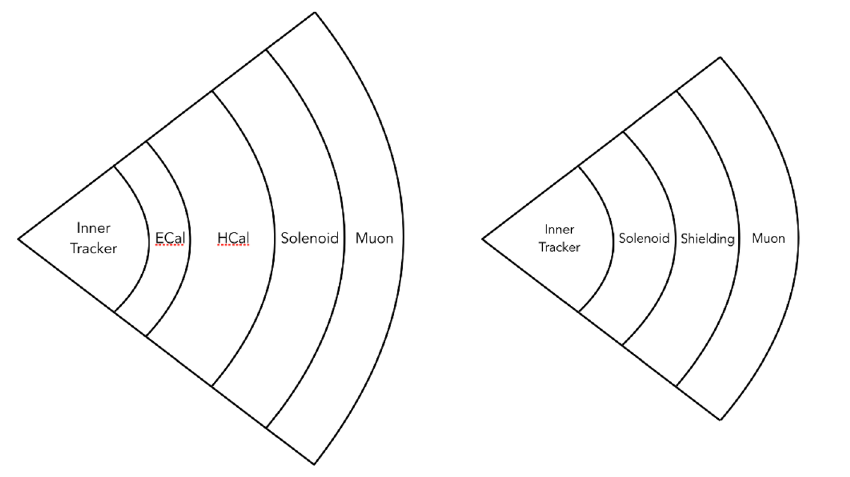
Figure 1 . Cartoon comparing a transverse wedge slice of a general purpose collider detector (left) with a similar slice of a magnetic solenoid tracking detector (right). The inner tracker systems are similar in both detectors. The general purpose detector has electromagnetic and hadronic calorimeter systems outside the inner tracker. The magnitude of the solenoidal magnetic (cid:12)eld in the inner tracker region is similar in both detectors. However, the solenoid can be physically smaller in the tracking detector. In the general purpose detector the return yoke for the solenoid is embedded within the muon system. In the tracker detector the return yoke can be part or all of the shielding material outside the